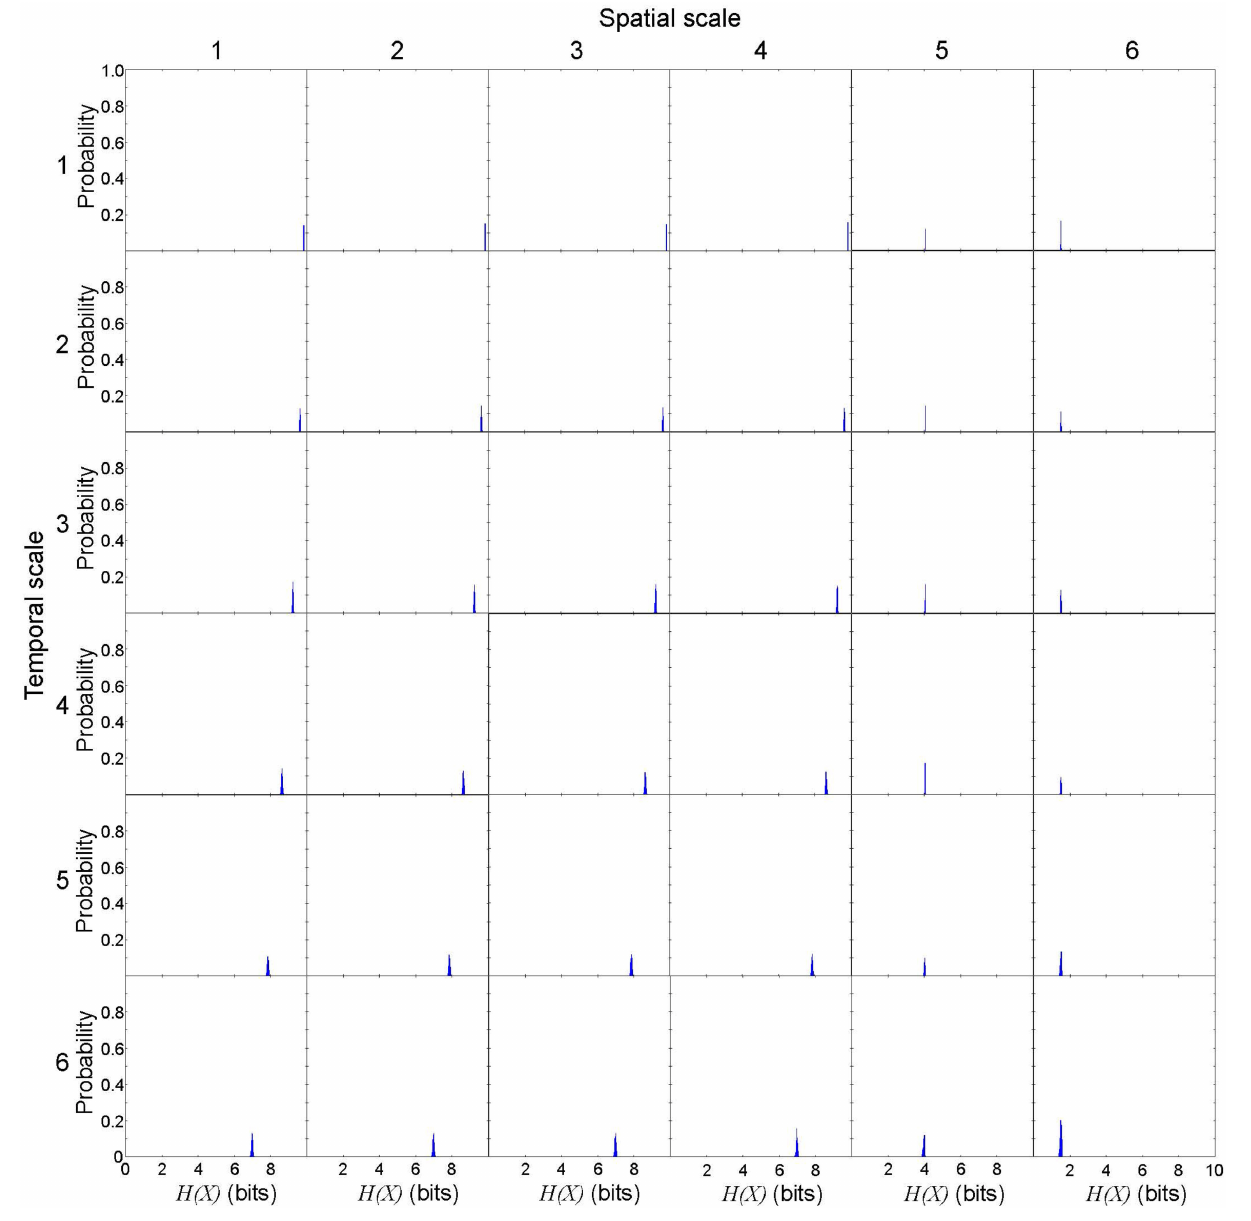
FIGURE 3 | Entropy of unconstrained probability distribution of possible cause X in a representative spiral wave data set. H ( X ) is not uniquely determined due to the discretization effect, but the variance is small. Each subplot represents he probability distribution of H ( X ). The columns represent the spatial scales (1 through 6) and the rows represent the temporal scales (1 through